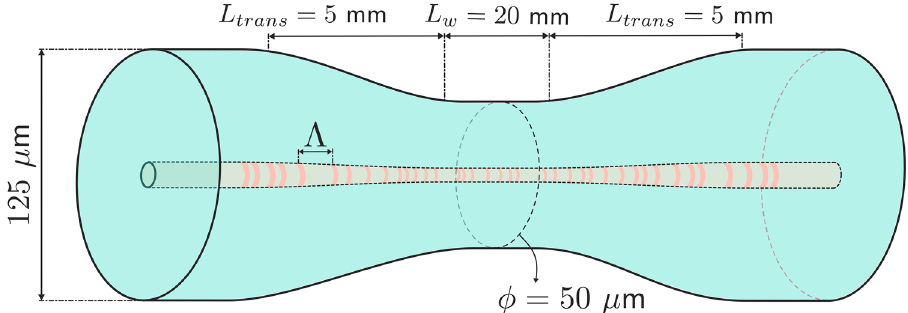
Figure 2. Schematic illustration of the 50 µm-waist tapered SMF, in which micro-modifications were applied using the femtosecond laser inscription setup.